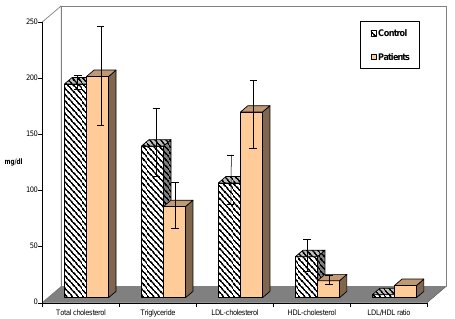
Figure1: Mean (±SE) serum lipid profile (total cholesterol, LDL-cholesterol, Triglyceride, and HDL-cholesterol) levels and LDL/HDL ratio in fasting Brucellosis patients (n = 20) and control groups (n= 15) the deference is significant. Circulating concentrations of glutathione, higher in patients with brucellosis than in control groups (mean  SE 2.49  0.4).